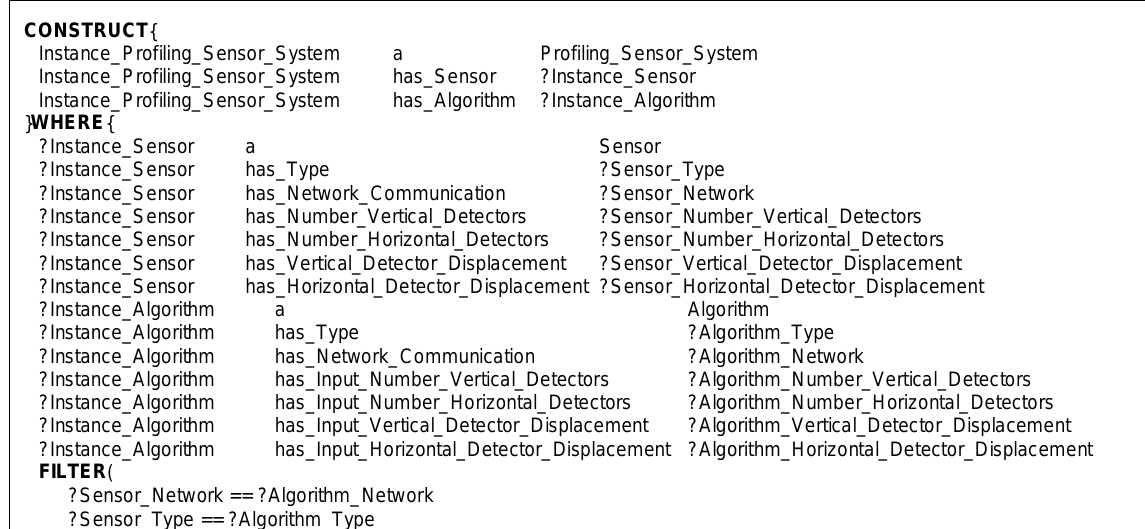
Figure 17. Sample Profiling_Sensor_System rule and instance diagram. The rule returns an instance if the Algorithm instance and Sensor instance properties: type, network communication, number of detectors, and displacement properties are